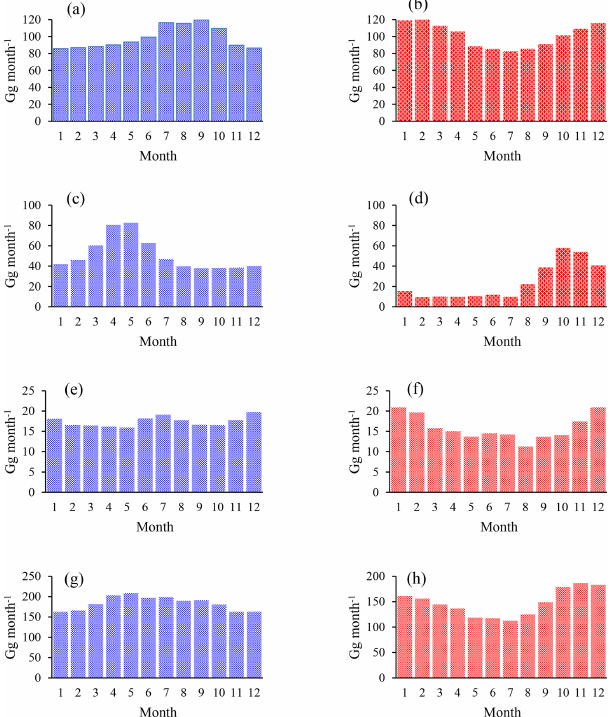
Figure 3. Chloromethane emissions in Ggmonth − 1 for the North- ern (a, c, e, g) and Southern Hemisphere (b, d, f, h) . (a, b) Com- bined emissions from higher plants and the unknown source, (c, d) biomass burning, (e, f) ocean net emission fluxes, and (g, h) total emissions. The emissions from the other known sources are constant over time, with 22.8Ggmonth − 1 in the Northern Hemisphere and 7.6Ggmonth − 1 in the Southern